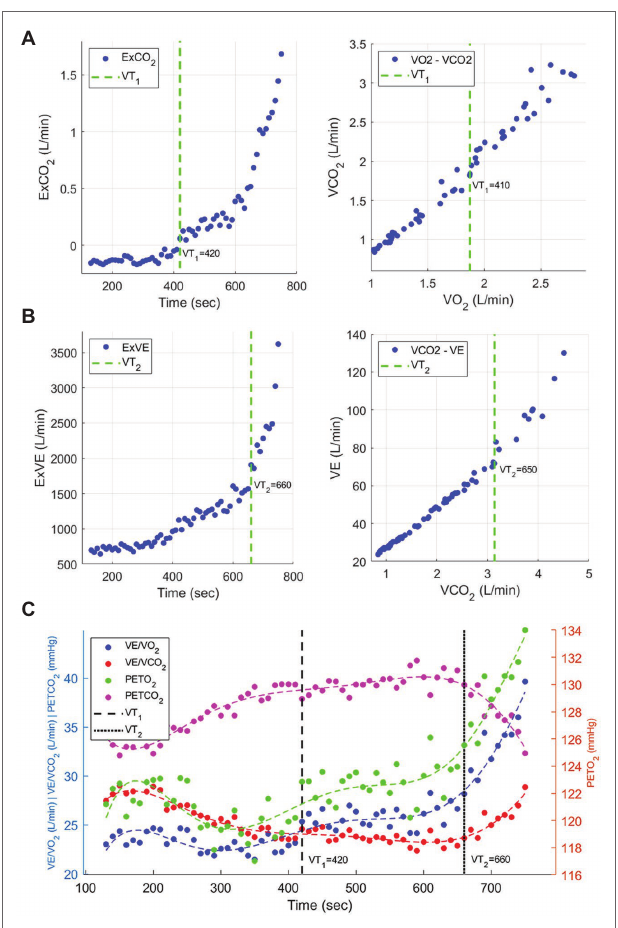
FIGURE 1 | Example of determination of VT 1 and VT 2 . (A) left: ExCO 2 , right: V-slope for VT 1 . (B) left: ExVE, right: V-slope for VT 2 . (C) The combined VT 1 and VT 2 corresponded to gas exchange data: VE/VO 2 , ventilatory equivalent for O 2 (blue dots); VE/VCO 2 , ventilatory equivalent for CO 2 (red dots); PETO 2 , end-tidal pressure of O 2 (green dots); end-tidal pressure of CO 2 , PETCO 2 (pink